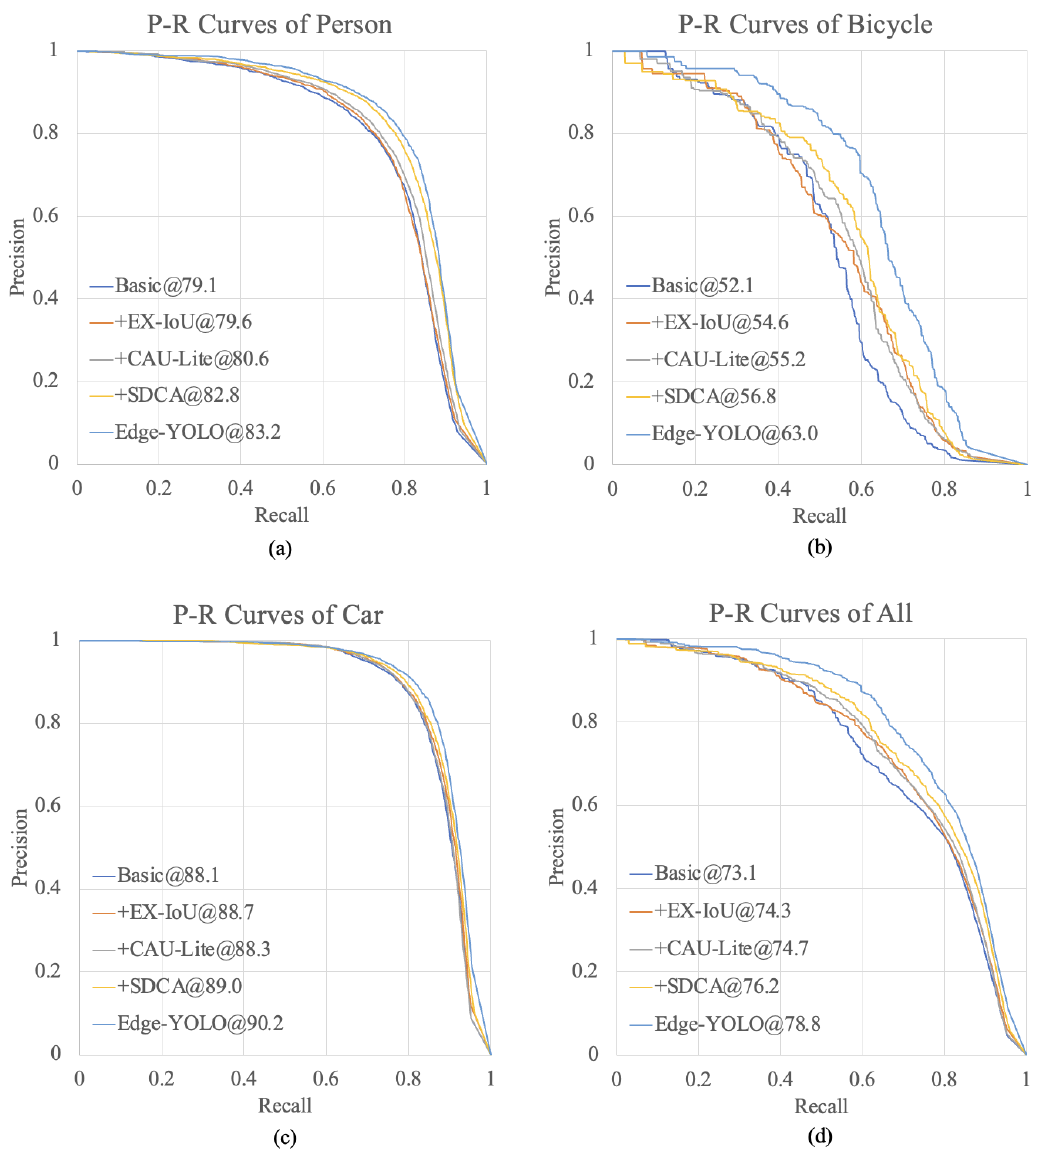
Figure 7. P–R curves for each class. ( a ): P-R curves of the class ‘Person’; ( b ): P-R curves of the class ‘Bicycle’; ( c ): P-R curves of the class ‘Car’; ( d ): P-R curves of all classes.